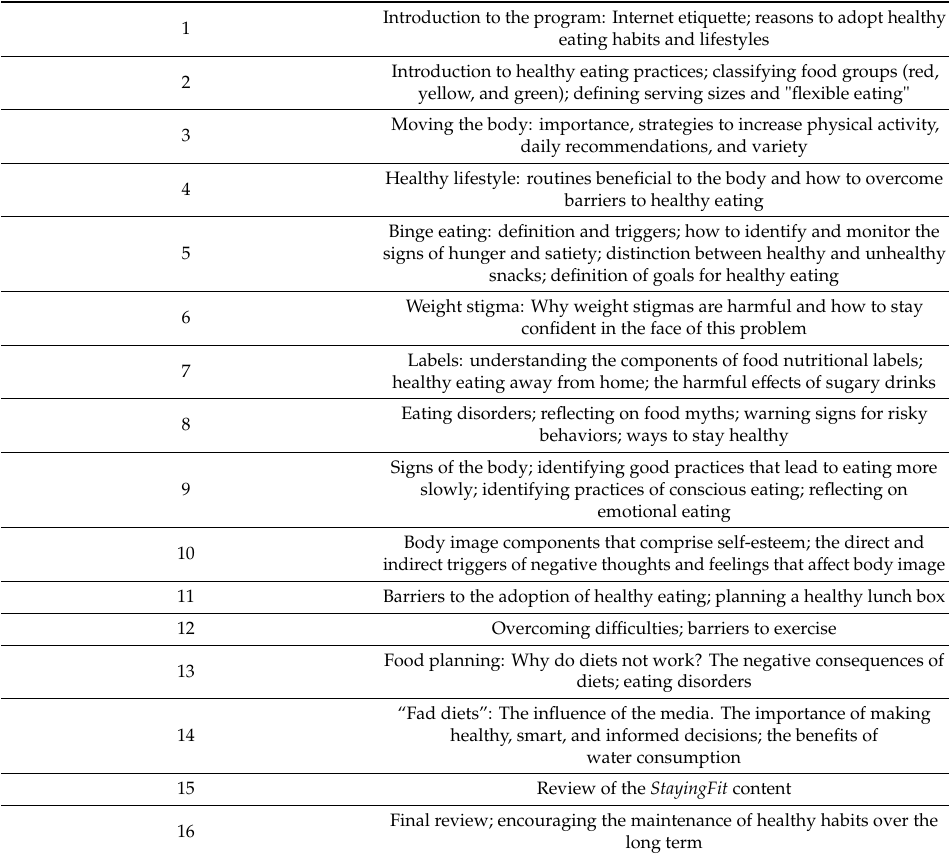
Table 2. Topics / content of the StayingFit Brazil